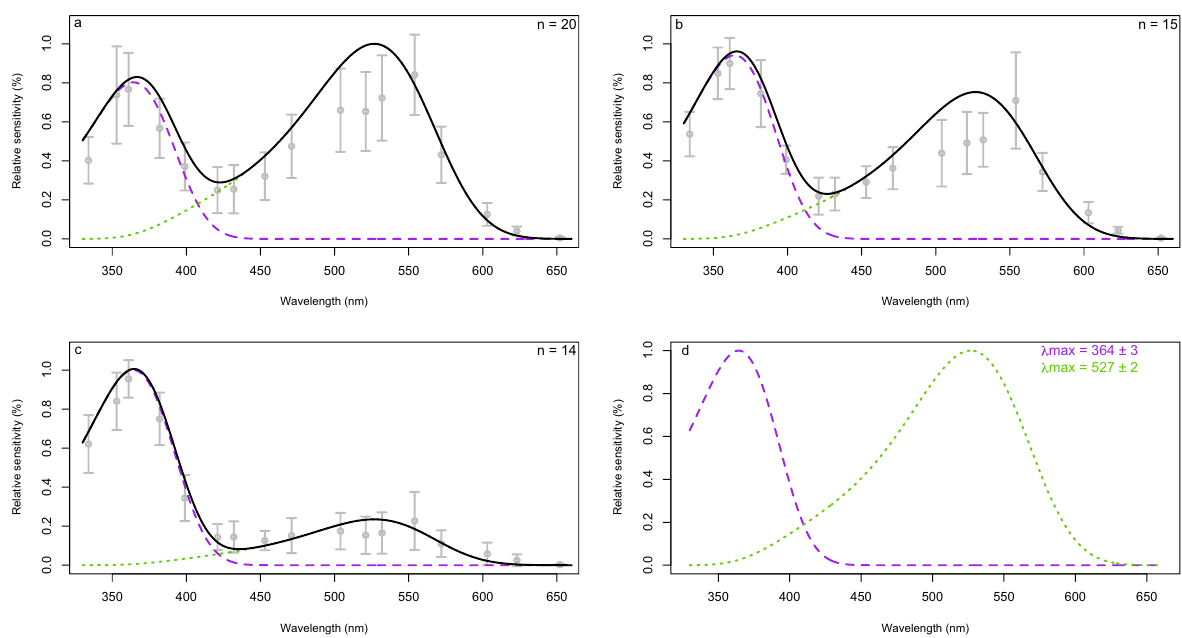
Figure 1. Spectral sensitivity of the compound eyes of S. noctilio determined by ERG after ( a ) dark adaptation (n = 10 males and 10 females), ( b ) dim green light adaptation (n = 7 males and 8 females), and ( c ) bright green light adaption (n = 7 males and 7 females). Normalized spectral sensitivity of the two types of receptors ( d ). Grey circles represent the relative sensitivity (%) measured from ERGs (mean ± standard deviation). Dashed (purple) and dotted (green) lines indicate the ∆(Qi) of the UV and LW receptors, respectively, under each adaptation. The black line shows the sum of the relative contribution of the UV and LW receptor model multiplied by the respective scaling factors for each